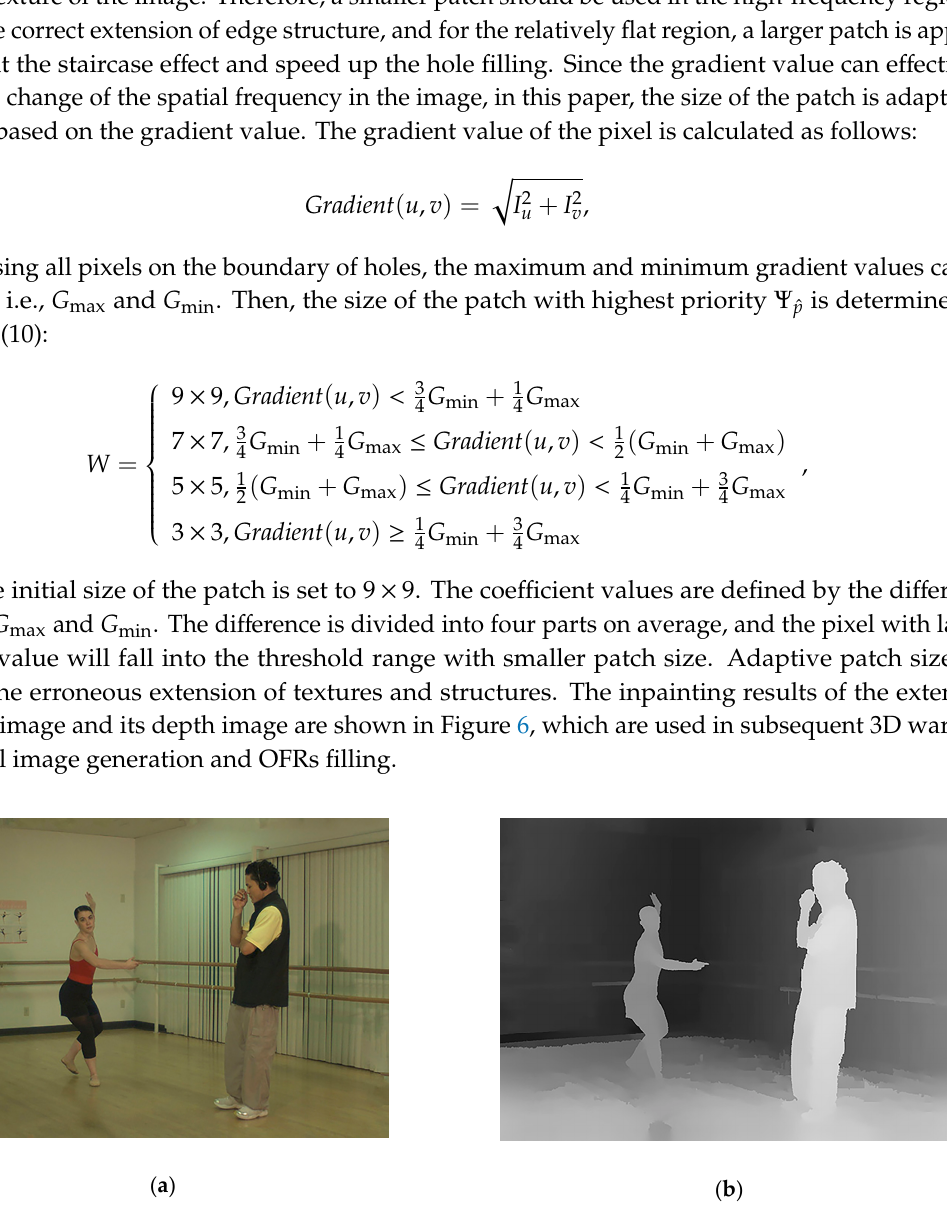
Figure 6. Inpainting results of extended reference image and its depth image: ( a ) Inpainting result of extended reference image; and ( b ) inpainting result of extended depth image.